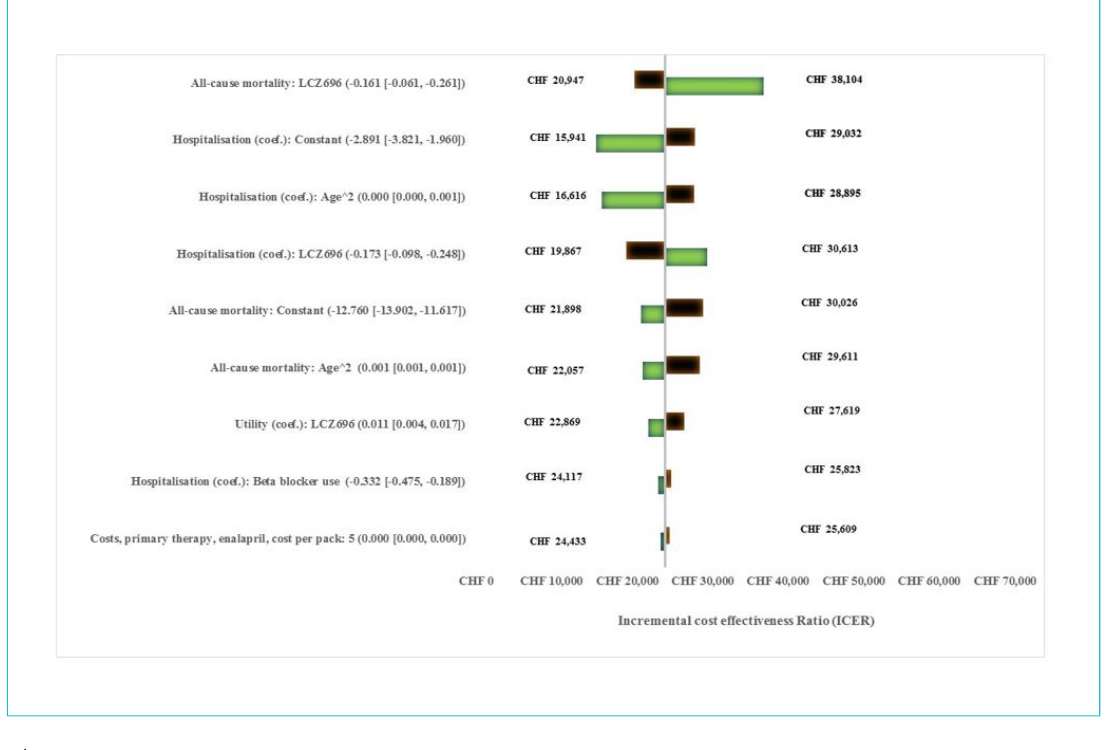
Table 2: Results of scenario